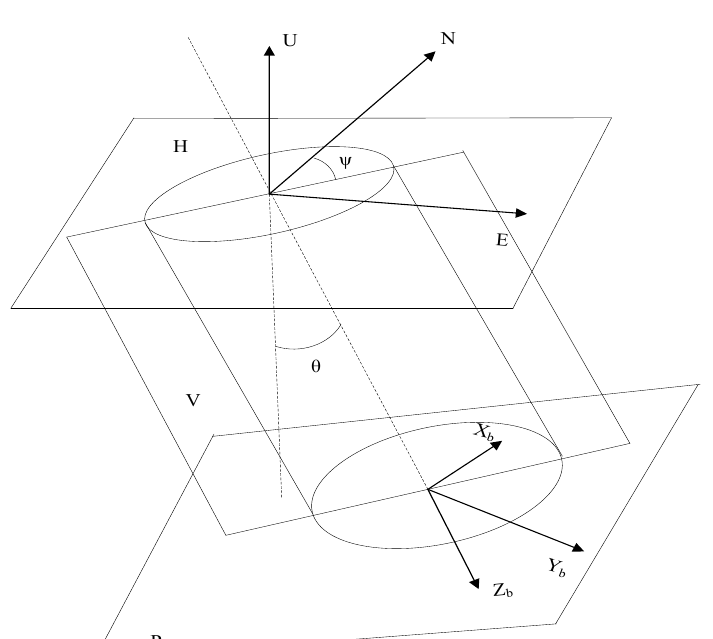
Figure 4. Attitude angle